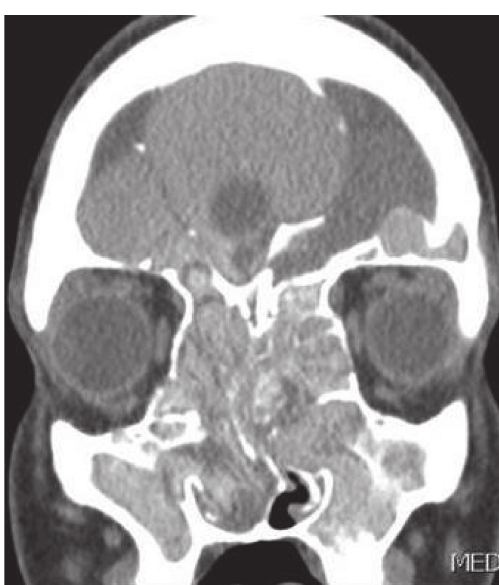
Figure 1: Computed tomography of the paranasal sinuses in the coronal plane, showing extensive disease with marked expansion of the sinuses, more pronounced in the right frontal